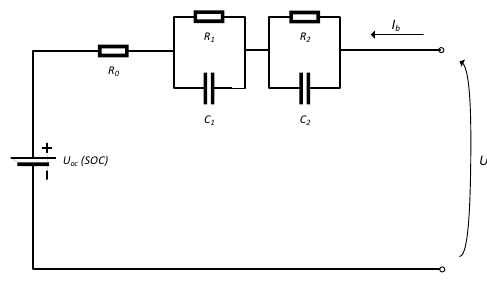
Figure 1. Second-order Resistor-Capacitor (RC) equivalent circuit